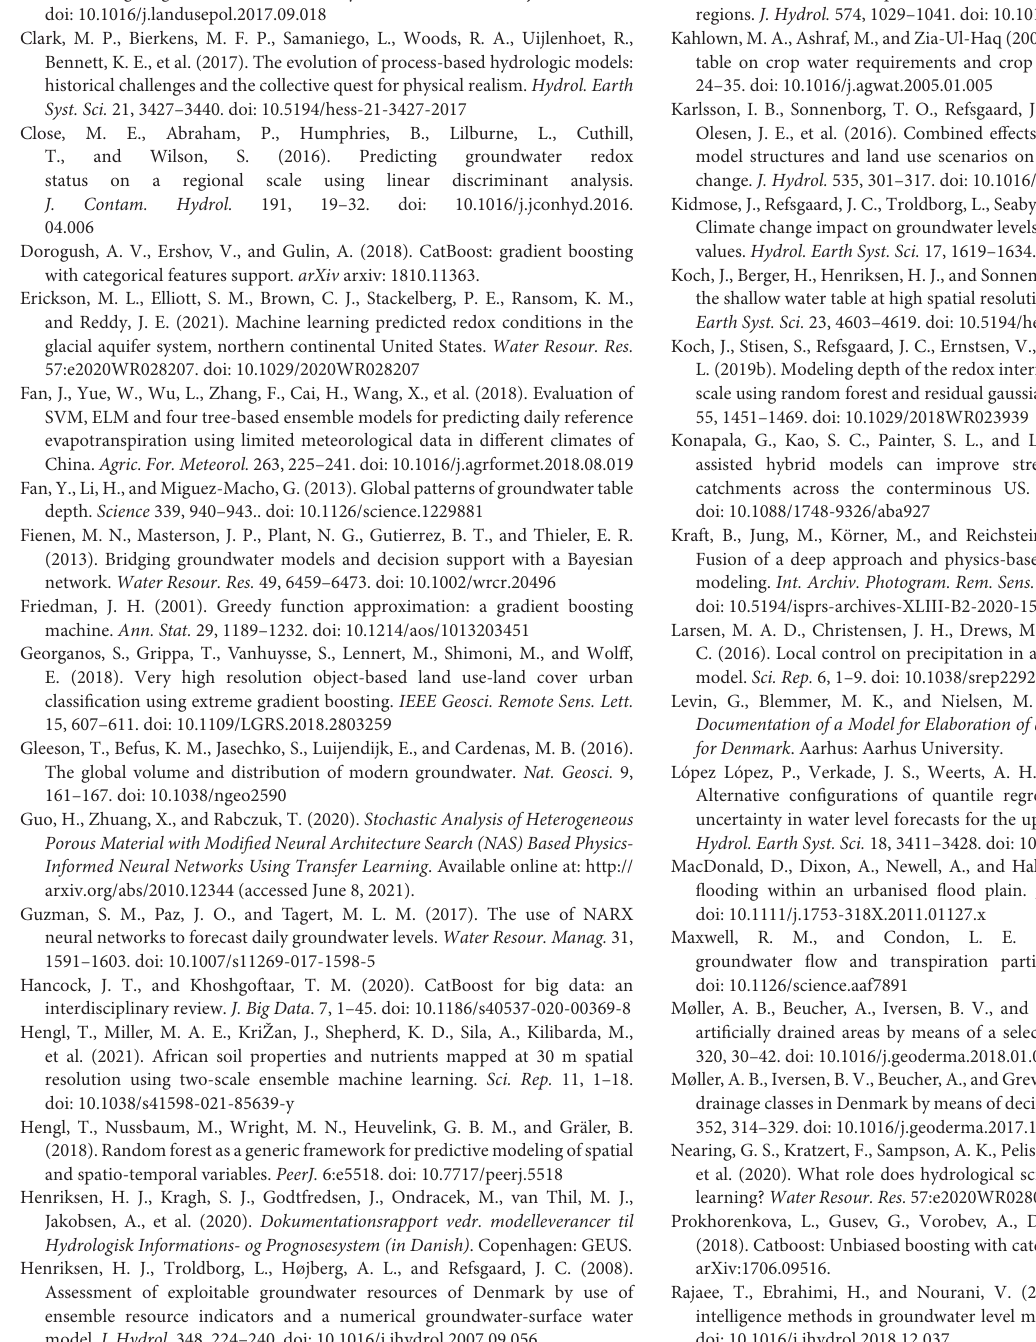
table on crop water requirements and crop yields. Agric. Water Manag. 76, 24–35. doi: